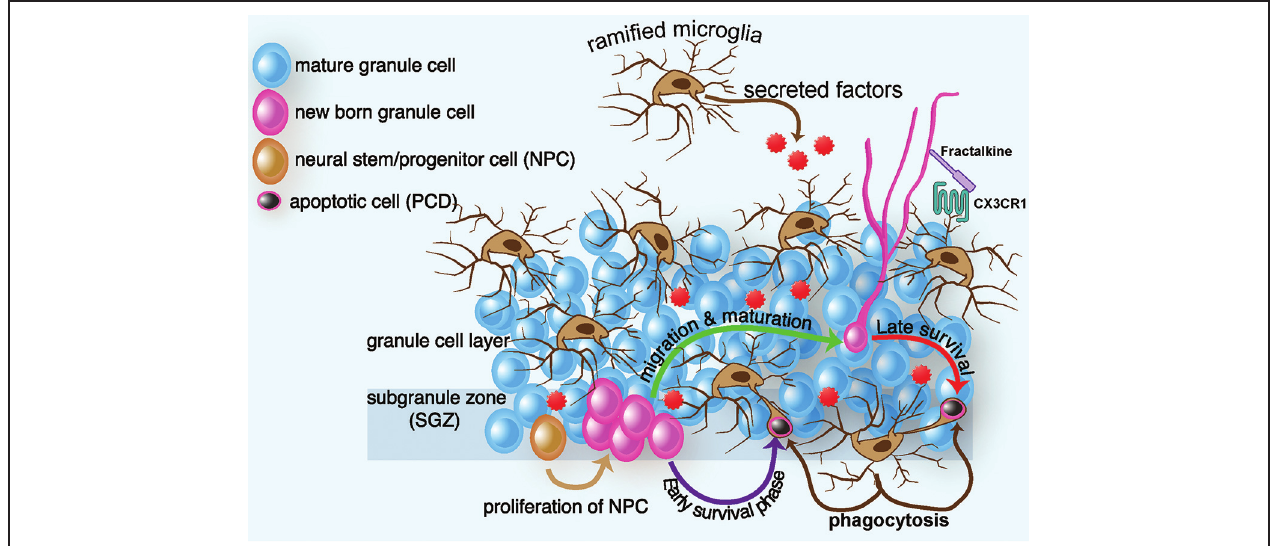
phagocytosis occurs by a special modification of the microglial processes, which form phagocytic pouches that engulf the apoptotic cells. Microglia can also affect proliferation, differentiation, and survival, through the secretion of neurotrophic factors. Finally microglia communicate with nearby neurons through the CX3CR1/CX3CL1 signaling. Interactions between CX3CL1 and CX3CR1 contribute to the ability of microglia to maintain a surveillant/ramified phenotype. Disruption of this signaling results in a change in microglia phenotype and function, which leads to decreased hippocampal